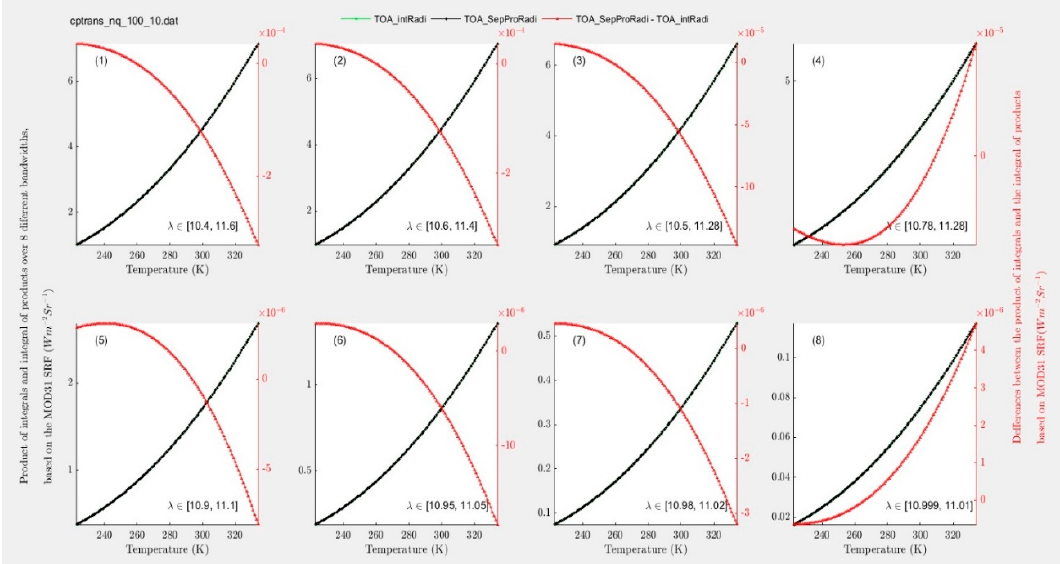
Figure 5 . Distributions of the simulated 𝐸𝑟𝑟𝑅𝑎𝑑 (cid:3036) 𝑠 which were calculated in the temperature range of [223,334] K with the Moderate Resolution Imaging Spectroradiometer (MODIS) band 31 spectral response function under the Cerro Pachón, Chile 10.0 water vapor and 2.0 air mass atmospheric conditions over seven artificial channel bands and the actual band of MODIS channel 31 (the 4th figure of the eight figures).